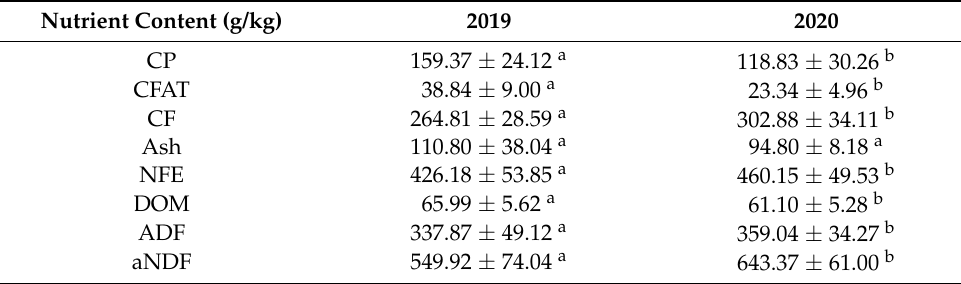
Table 7. Nutrient levels according to the year of harvest (g/kg of dry matter).